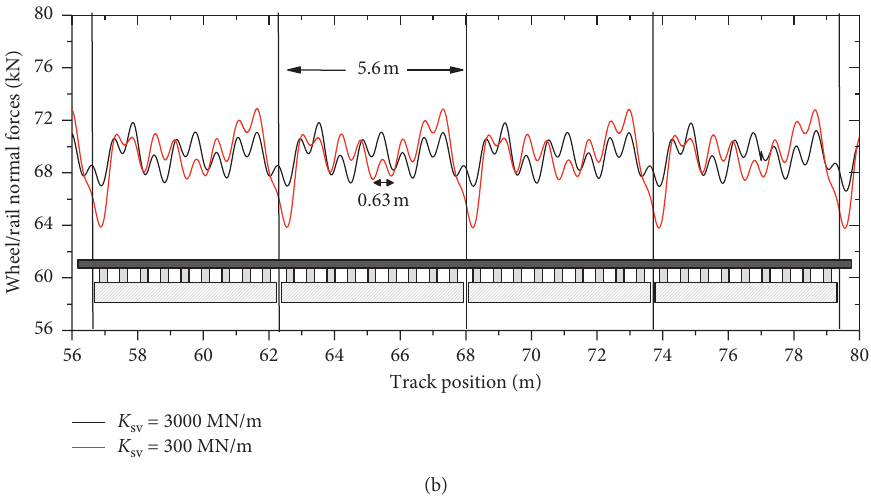
Figure 17: Dynamic responses due to discrete sleeper support and the slab segment: (a) axle box vertical acceleration; (b) wheel/rail normal forces.